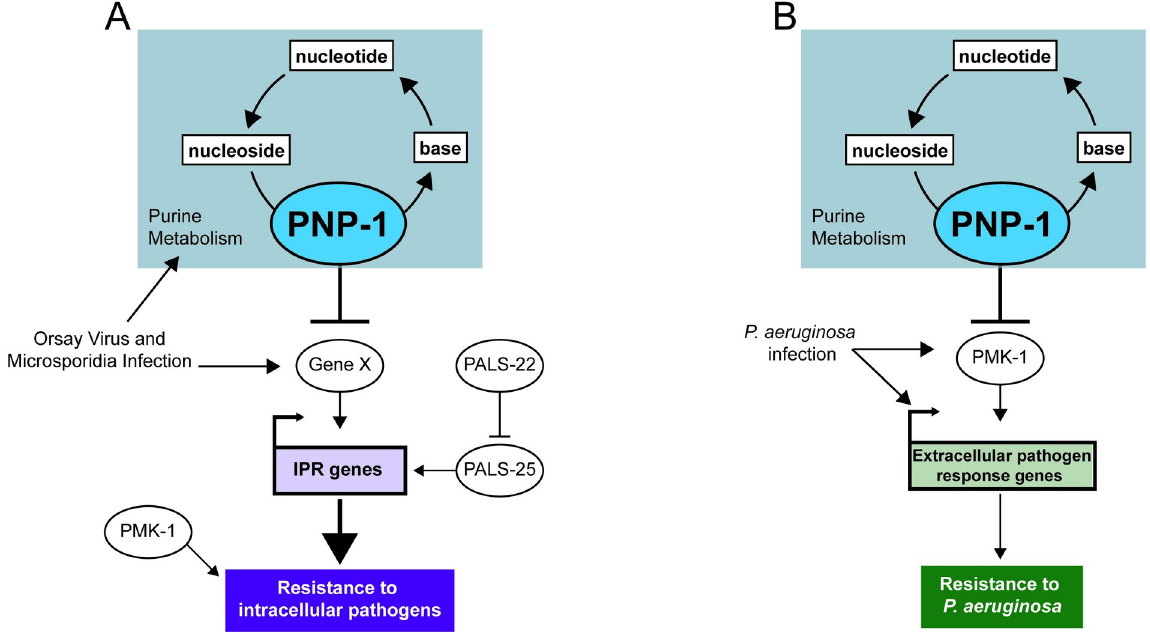
Fig 6. Model for pnp-1 regulation of immune responses. A) pnp-1 negatively regulates mRNA expression of IPR genes induced by infection with the intracellular pathogens the Orsay virus and N . parisii (microsporidia). Loss of pnp-1 or pals-22 results in constitutive expression of IPR genes and resistance to the Orsay virus and N . parisii . Epistasis analysis indicates that pnp-1 acts in parallel to pals-22/pals-25 . pmk-1 ( p38 MAPK) mutants display increased susceptibility to N . parisii as compared to wild-type animals. Because IPR genes are distinct from pmk-1 - regulated genes, we favor a model where pmk-1 acts in parallel to the IPR. B) pnp-1 negatively regulates genes that are induced by various extracellular pathogens and pnp-1 mutants are resistant to infection by the extracellular Gram-negative pathogen P . aeruginosa . Resistance to P . aeruginosa in pnp-1 mutants requires pmk-1 . In addition, upregulation of genes induced by wild-type pmk-1 in pnp-1 mutants requires functional pmk-1 , suggesting that here, pnp-1 functions upstream of pmk-1 .